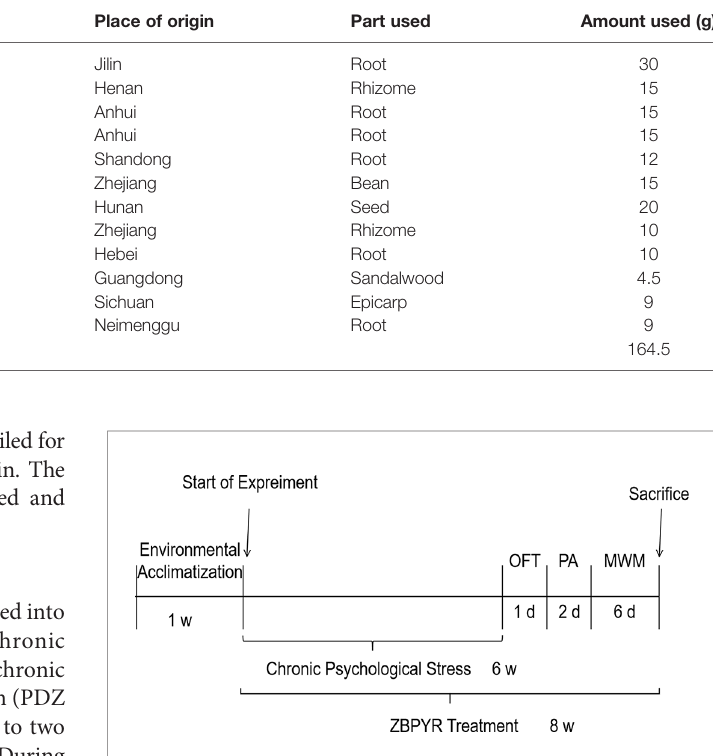
FIGURE 1 | Experimental process. OFT, open fi eld test; PA, passive avoidance test; MWM, the Morris water maze